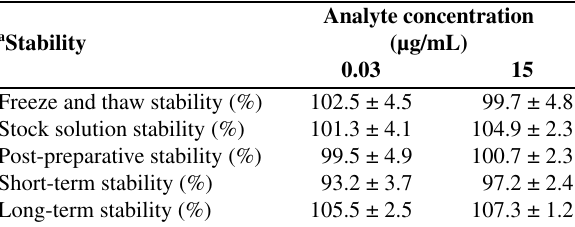
Table 4. Stability of TPM in stock solution and in human plasma under various storage